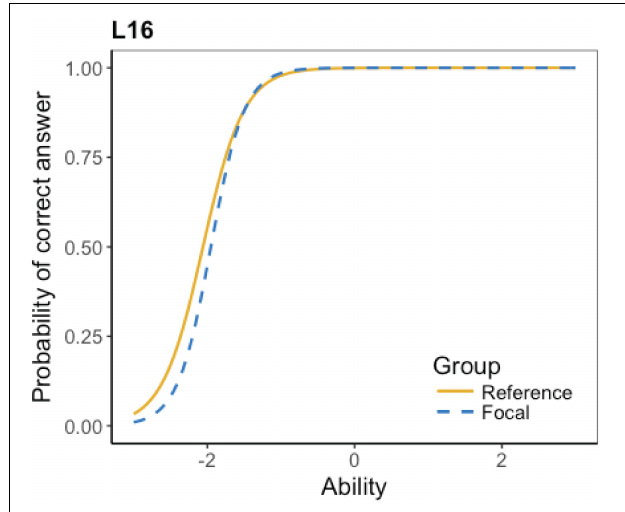
FIGURE 1 | ICC of listening L16.